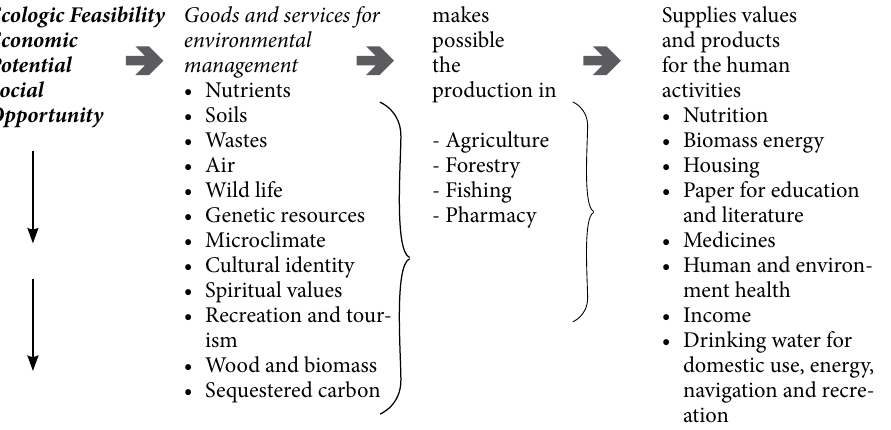
Ecologic Feasibility Economic Potential Social